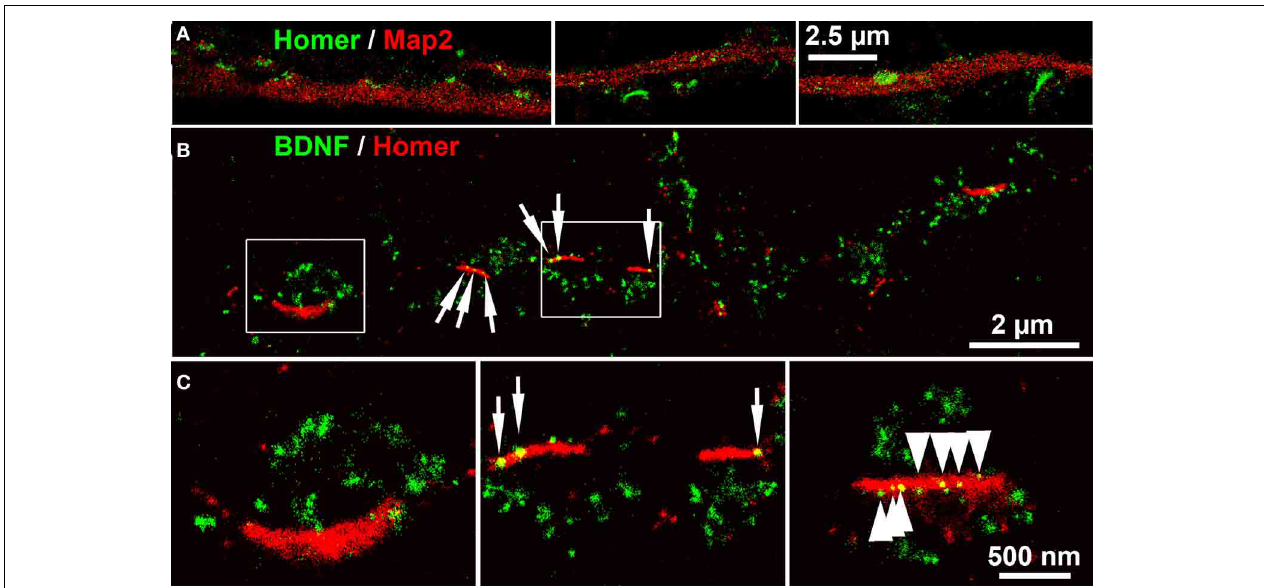
FIGURE 8 | d STORM images of BDNF localization at postsynaptic bar structures (DIV 30). (A) Homer + bar structures are assembled along, but not within Map2 + dendrites. (B) BDNF + vesicles accumulate in juxtaposed position to Homer + postsynaptic bars, while only a low number of BDNF + localizations (6.7%) were found at postsynaptic bar structures (white arrows). (C) ( left panel, detail of B) The inner bow of